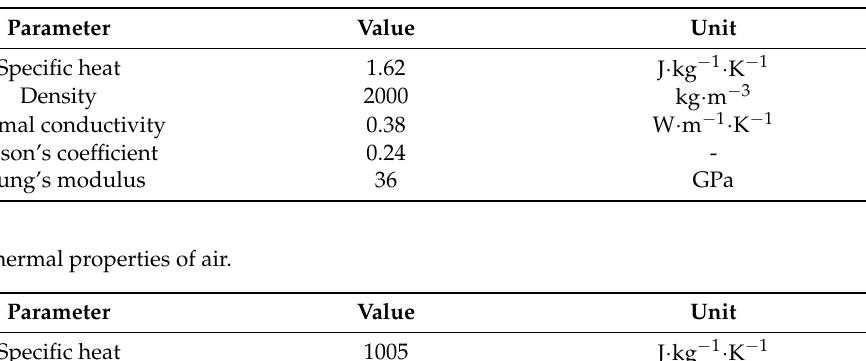
Figure 5. Model of composite where 1, 2, and 3 correspond to the defects 1, 2, and 3, respectively. Table 1. Thermal and strength properties of the composite [26].